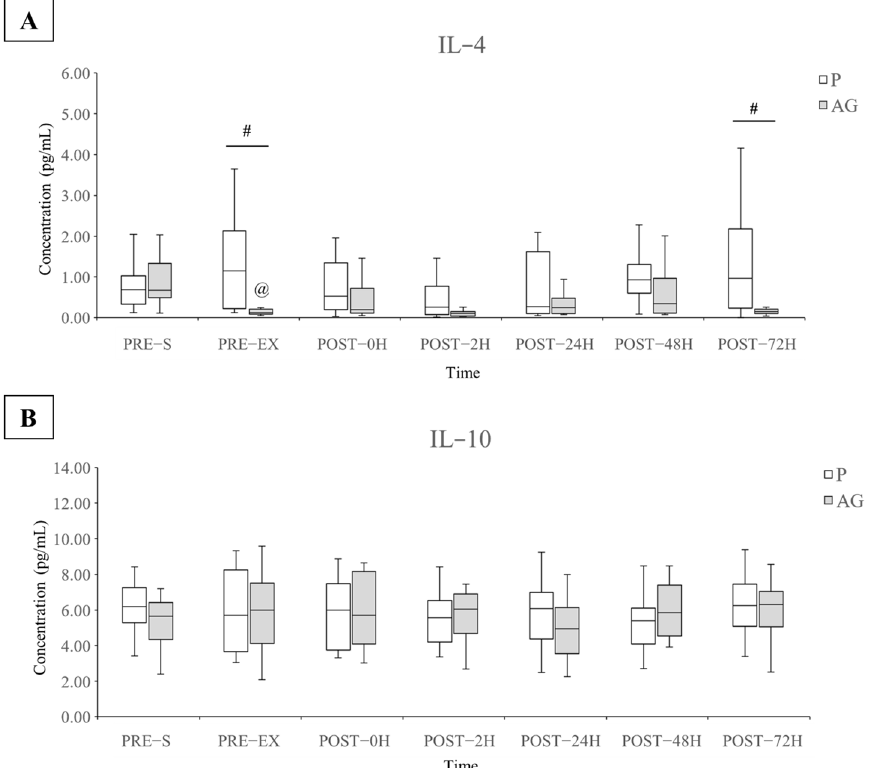
Figure 5. Levels of plasma IL-4 and IL-10 during the experimental period ( N = 12). Q1, median, Q3, minimum, and maximum values of IL-4 ( A ) and IL-10 ( B ) are presented in boxplots. @ p < 0.05 vs. PRE-EX; # p < 0.05 between P and AG supplementation. AG: American ginseng; IL-4: interleukin-4; IL-10: interleukin-10; P: